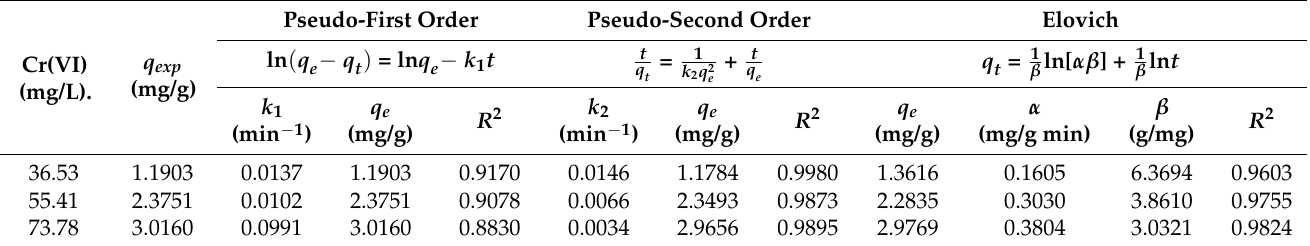
Table 1. Kinetic constants and correlation factors for Cr(VI) absorption, analyzed by pseudo-first and second order and by Elovich model.